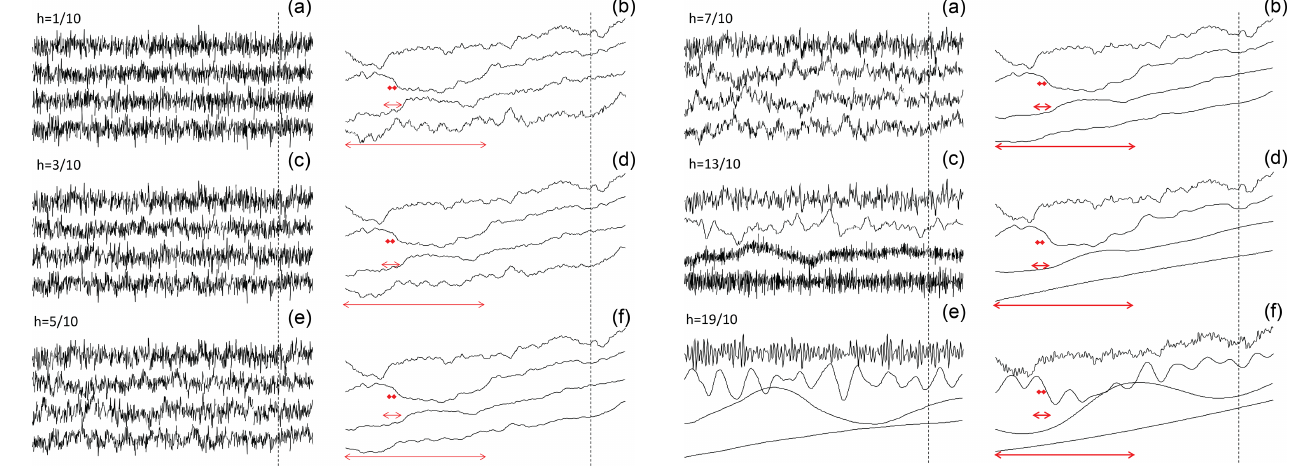
Figure 6. fRn and fRm simulations (left and right columns respec- tively) for h = 1 / 10, 3 / 10, and 5 / 10 (top to bottom sets, all with α = 0), i.e. the exponent range that overlaps with fGn and fBm. There are three simulations, each of length 2 19 pixels, and each uses the same random seed with the unit scale equal to 2 10 pixels (i.e. a resolution of τ = 2 − 10 ). The entire simulation therefore covers the range of scale 1 / 1024 to 512 units. The fRm on the right is from the running sum of the fRn on the left. Starting at the top line of each set, we show 2 10 points of the original series degraded in resolution by a factor 2 9 . Since the length is t = 2 9 units long, each pixel has resolution τ = 1 / 2. The second line of each set takes the segment of the upper line lying to the right of the dashed vertical line, 1 / 8 of its length. It therefore spans t = 0 to t = 2 9 / 8 = 2 6 , but resolution was taken as τ = 2 − 4 , and hence it is still 2 10 pixels long. Since each pixel has a resolution of 2 − 4 , the unit scale is 2 4 pixels long: this is shown in red in the second series from the top (middle set). The process of taking 1 / 8 and blowing up by a factor of 8 continues to the third line (length t = 2 3 , resolution τ = 2 − 7 ), unit scale = 2 7 pixels (shown by the red arrows in the third series), until the bottom series which spans the range t = 0 to t = 1, and resolution τ = 2 − 10 with unit scale 2 10 pixels (the whole series displayed). Each series was rescaled in the vertical so that its range between maximum and minimum was the same. The unit relaxation scales indicated by the red arrows mark the transition from small to large scales. Since the top series in each set has a unit scale of 2 (degraded), it is nearly a white noise (a, c, e) or (ordinary) Brownian motion (b, d, f) . In con- trast, the bottom series is exactly of length t = 1, so that it is close to the fGn and fBm limits (left and right) with the standard expo- nent H = h + 1 / 2. As indicated in the text, the second series from the top in the bottom set is most realistic for monthly temperature anomalies.